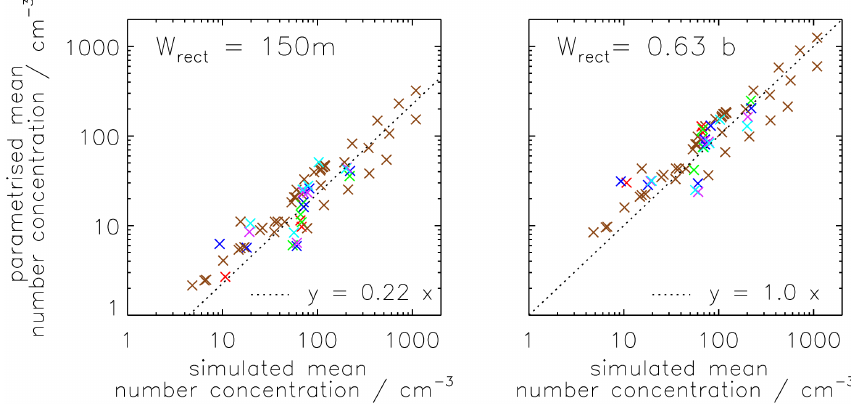
Figure 11. Simulated vs. parametrised mean ice crystal number concentration. In the simulation, the mean is taken over all grid boxes with non-zero ice crystal number concentration. The parametrised n mean is given by ˆ N surv /( ˆ H W rect ) . In the left panel, W rect is ˆ W = 150m. In the right panel, ˆ W is 0 . 63 b , where b is the wing